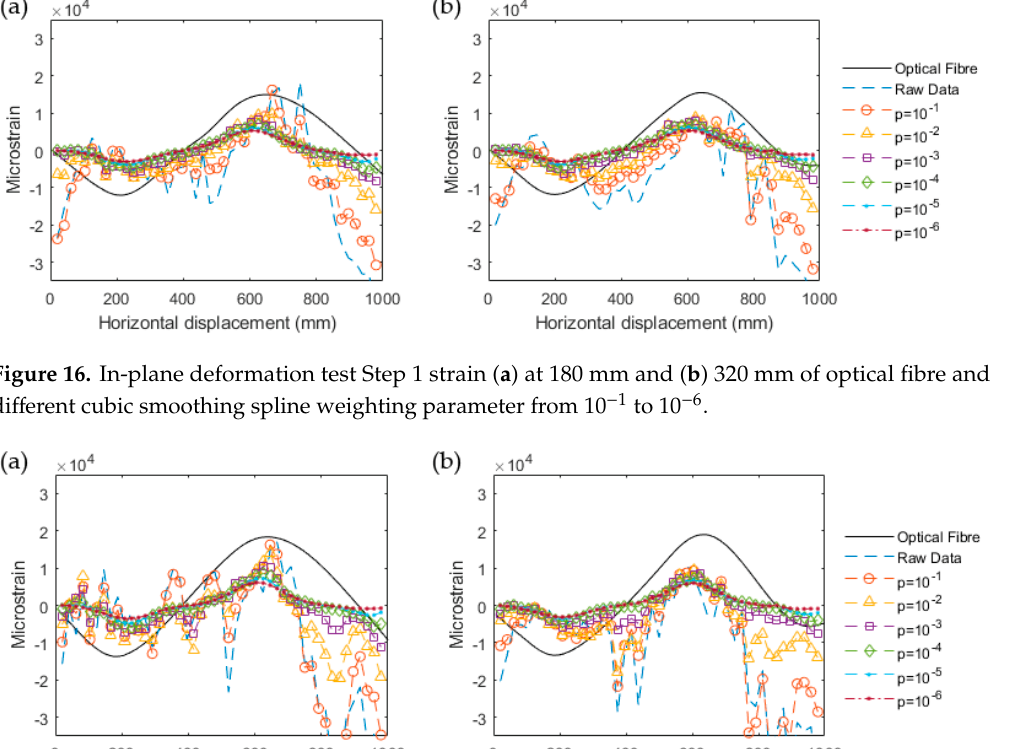
Figure 16. In-plane deformation test Step 1 strain ( a ) at 180 mm and ( b ) 320 mm of optical fibre and different cubic smoothing spline weighting parameter from 10 (cid:2879)(cid:2869) to 10 (cid:2879)(cid:2874) .